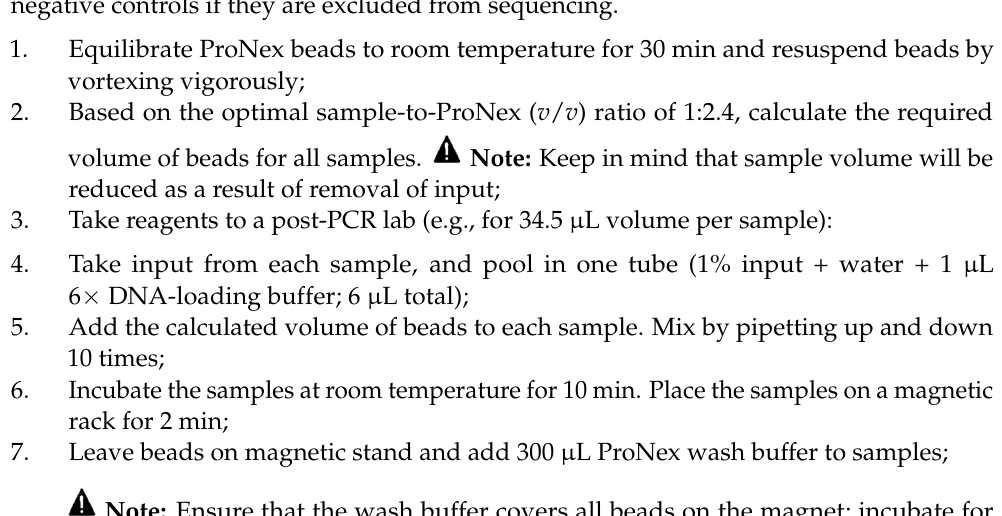
Table 8. Reverse Transcription